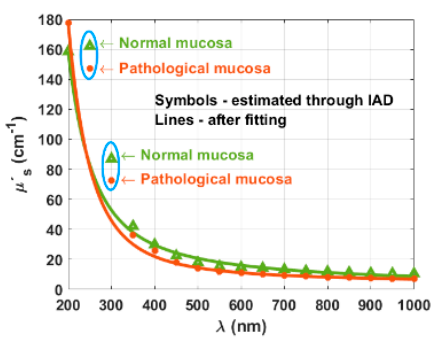
Figure 9. Estimated µ ′ s data and calculated fitting curve for the normal and pathological